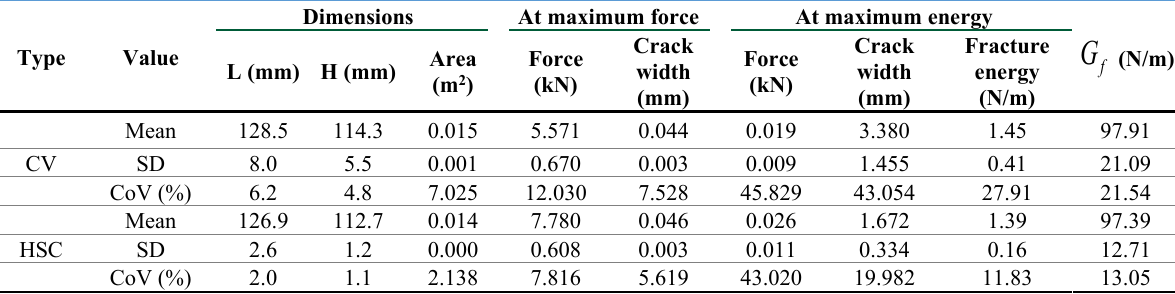
Table 2. Fracture test parameters, crack length and energy